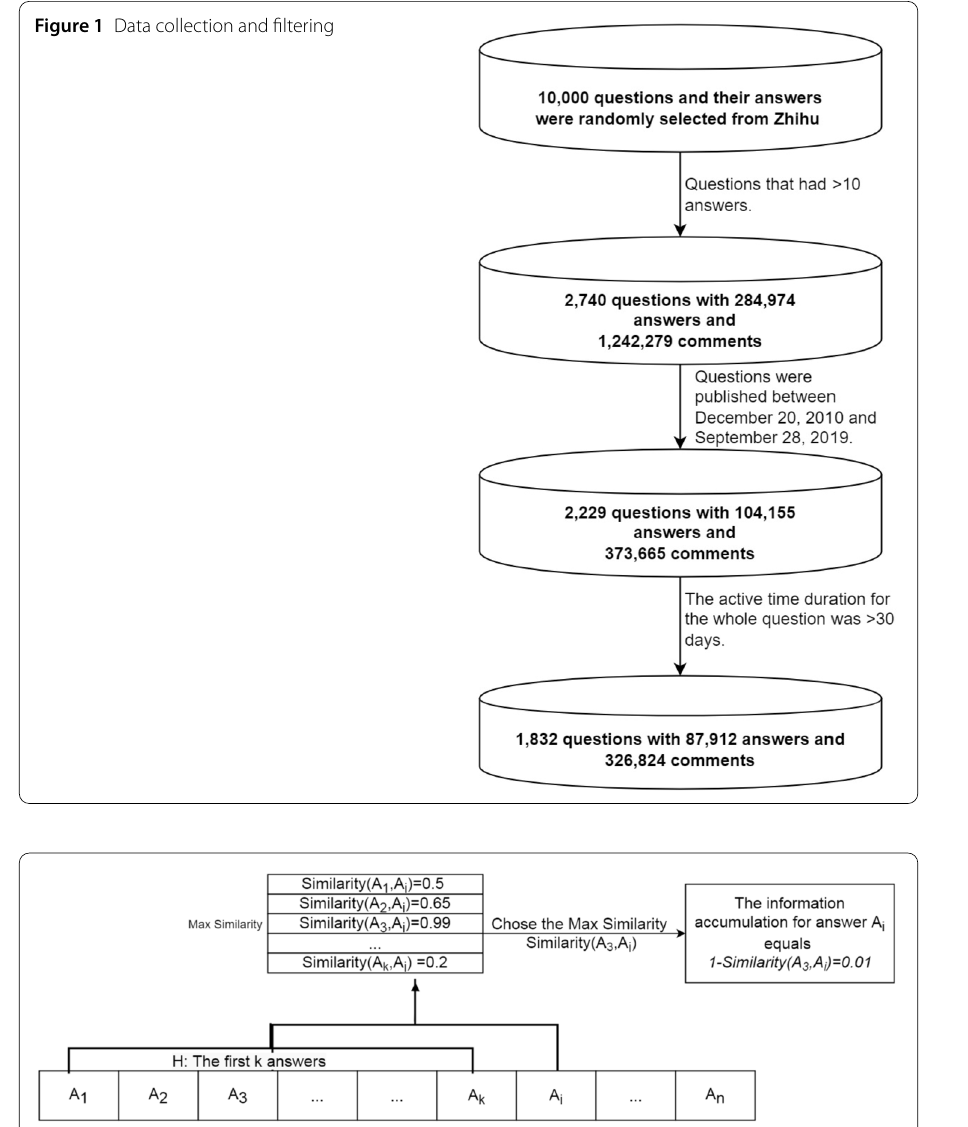
Figure 2 Schematic of information accumulation